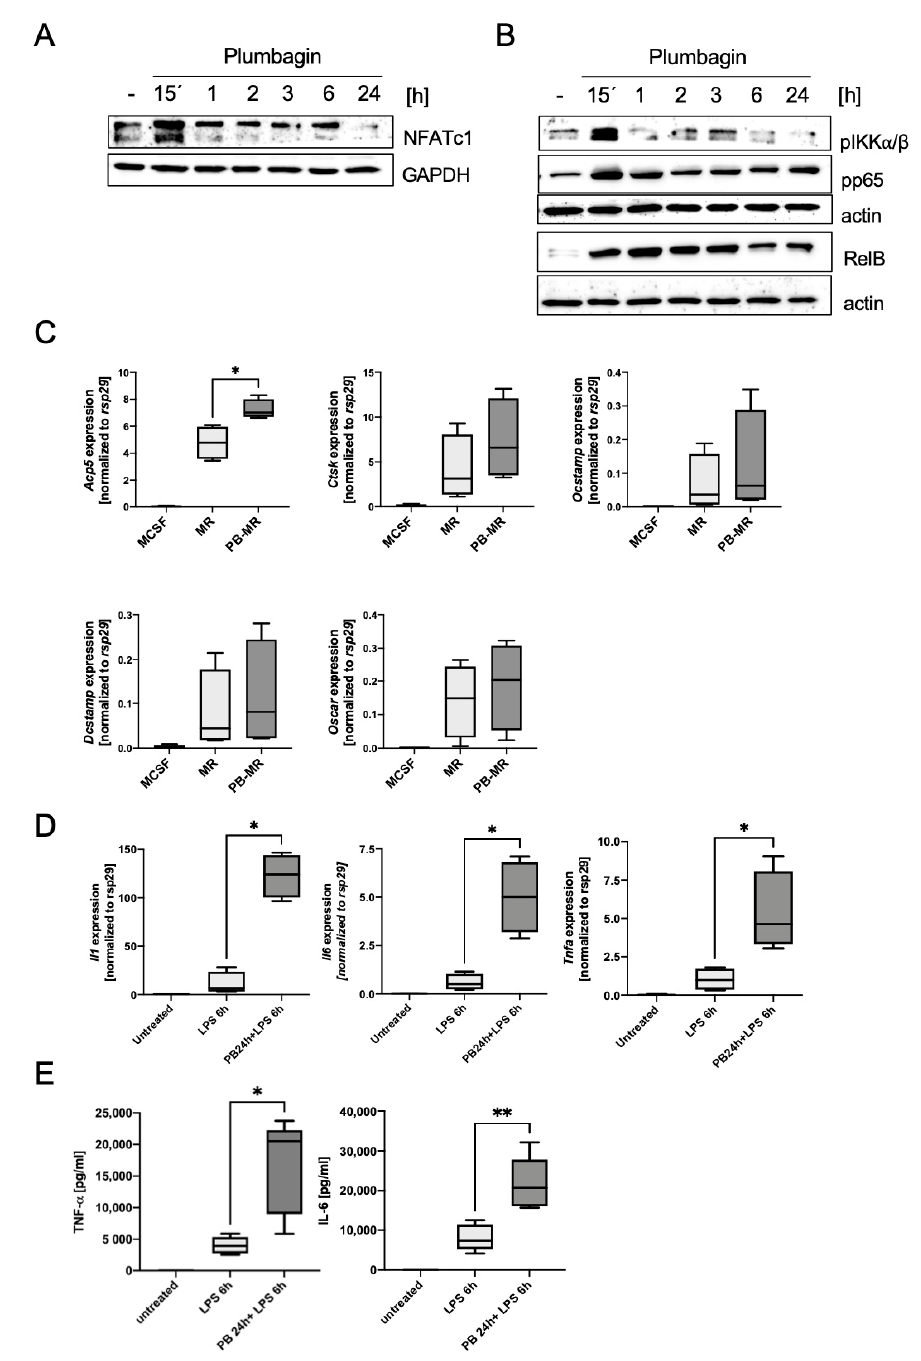
Figure 3. Plumbagin induces the rapid activation of cellular signalling in BMDMs: ( A , B ) Western blot analysis to test typical osteoclast signalling molecules was performed using antibodies against NFATc1 ( A ) and molecules of the NF- κ B pathway ( B ). GAPDH and actin were used as loading controls. The blots are typical examples out of three independent experiments; ( C ) differentiating osteoclasts were analysed on day 3 by RT-PCR to determine the expression of the osteoclastic marker genes Acp5, Ctsk, Ocstamp, Dcstamp and Oscar , respectively ( n = 4). Statistical analysis comparing the results to the positive control (M-CSF/RANKL) was performed using Mann–Whitney test; ( D , E ) BMDM were either pre-stimulated with plumbagin for 24 h before stimulation with 100 ng/mL LPS for 6 h or stimulated directly with LPS. ( D ) RT-PCR was performed to determine the expression of the osteoclastogenic, pro-inflammatory cytokine genes Il6, Il1 and Tnfa , respectively ( n = 4); ( E ) the supernatants of the samples were subjected to ELISA to determine the levels of produced cytokines ( n = 5). Statistical analysis comparing the results to the positive control (LPS) was carried out using a Mann–Whitney test in ( D ) and ( E ). *: p ≤ 0.05; **: p ≤